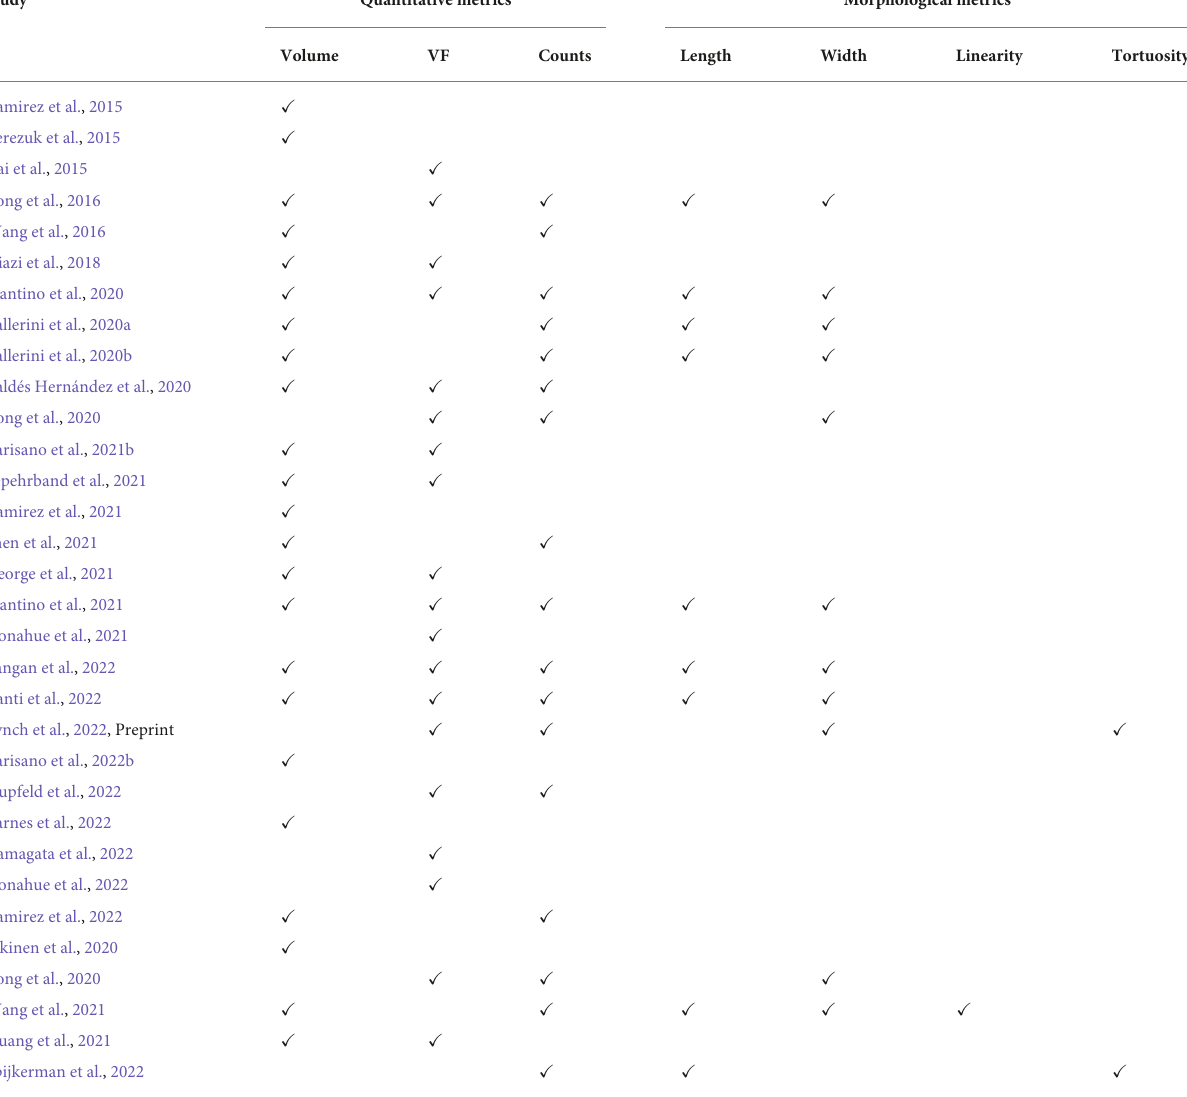
TABLE 3 Summary of the PVS metrics that have been investigated by previous